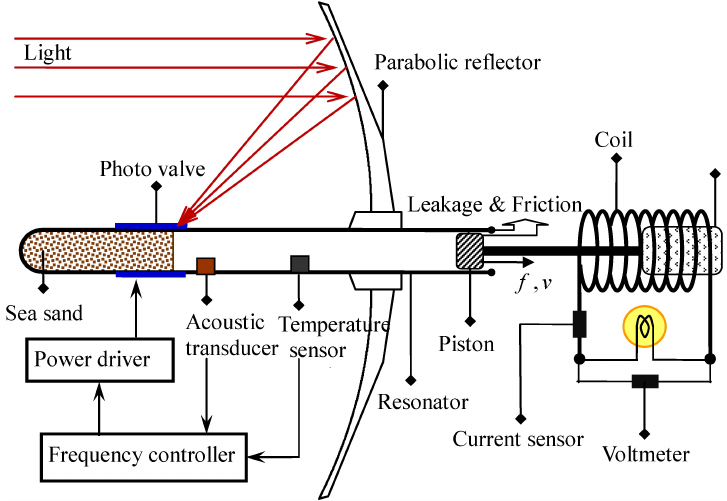
Figure 12. The design of a solar thermoacoustic engine